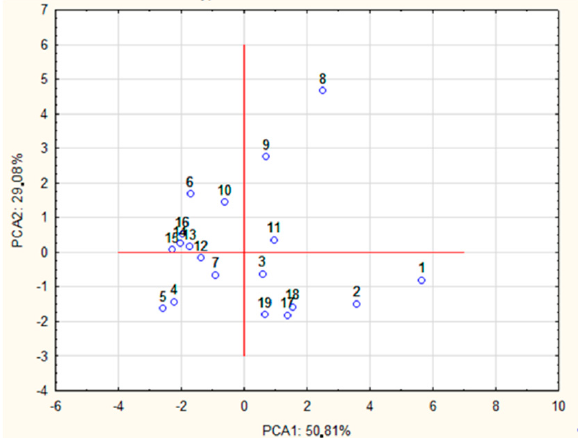
Figure 5. PCA of the olidosaccharides obtained by different hydrolytic treatments, where 1—AH + Rohapect MaPlusT (10 min), 2—AH + Rohapect MaPlusT (30 min), 3—AH + Pectinex UltraAFP (10